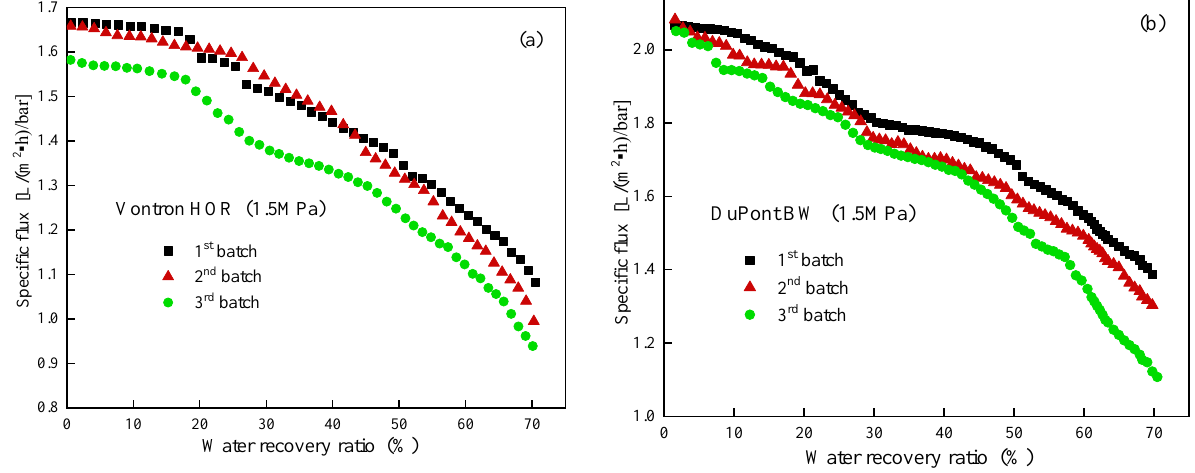
Figure 4. Changes in apparent specific flux with water recovery ratio for Vontron HOR ( a ) and DuPont Filmtec BW ( b ) RO membrane in 3 batch filtrations.